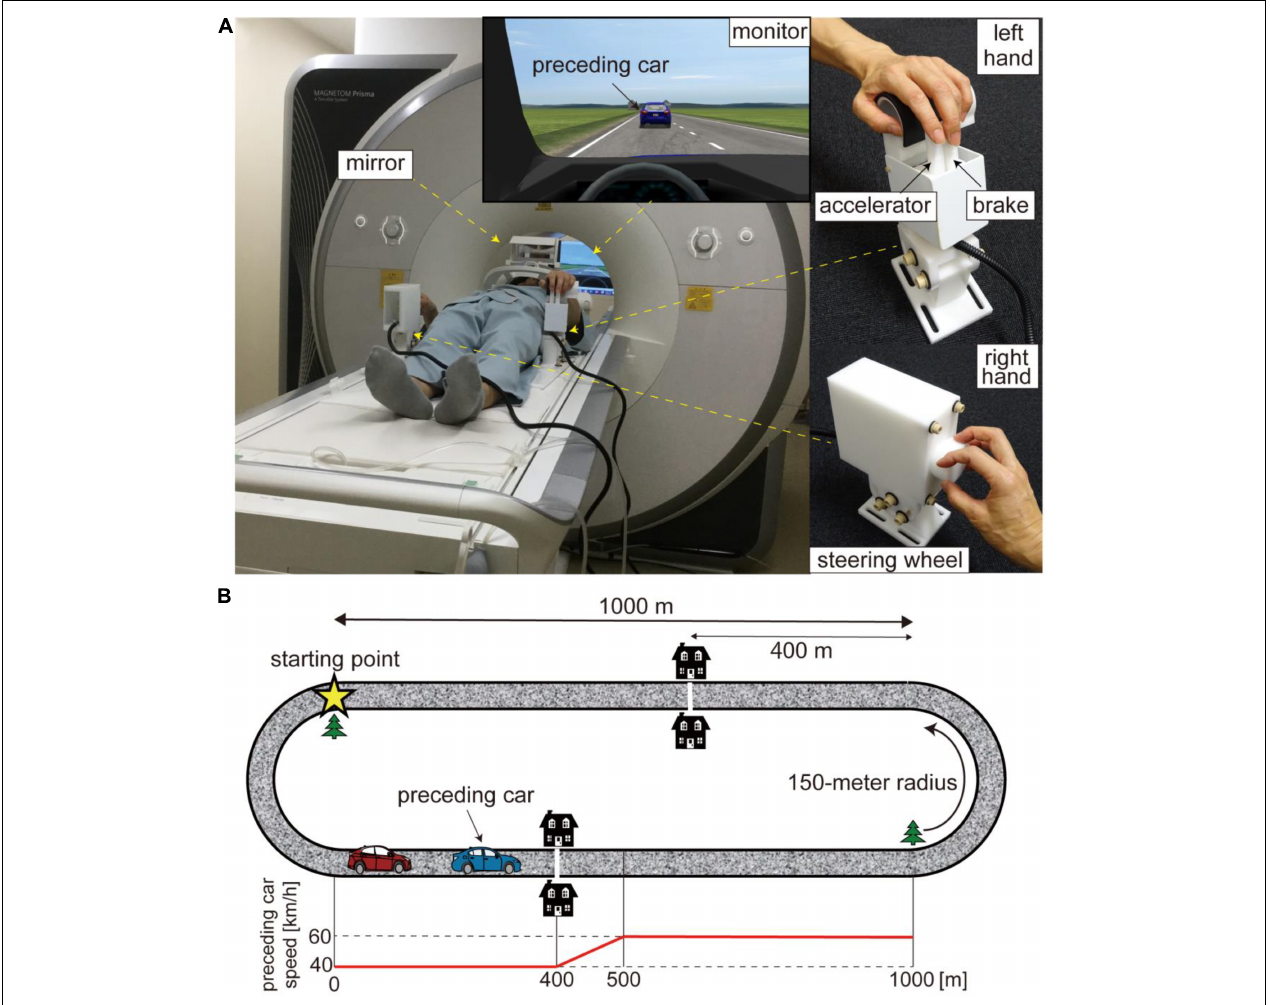
FIGURE 1 | (A) Experimental setup. Participants drove a virtual car while lying on the bed of an MRI scanner. The virtual car was controlled with MRI-compatible customized devices. The two levers manipulated with the index and middle fingers of the left hand served as brake and accelerator pedals (upper right) while the knob controlled with the right hand functioned as a steering wheel (lower right). Participants viewed a monitor via a mirror. (B) Driving course. The driving circuit consisted of 1,000-m straight sections and 150-m radius curves. The star denotes the starting point. The preceding car runs at 40 km/h for the first 400 m of the straight section and accelerates from 40 to 60 km/h for the next 100 m. The white line and two houses were displayed to inform participants of the acceleration point of the preceding car. The bottom panel shows the trajectory of the preceding car’s speed. The trajectory is aligned to the beginning of the straight section (0